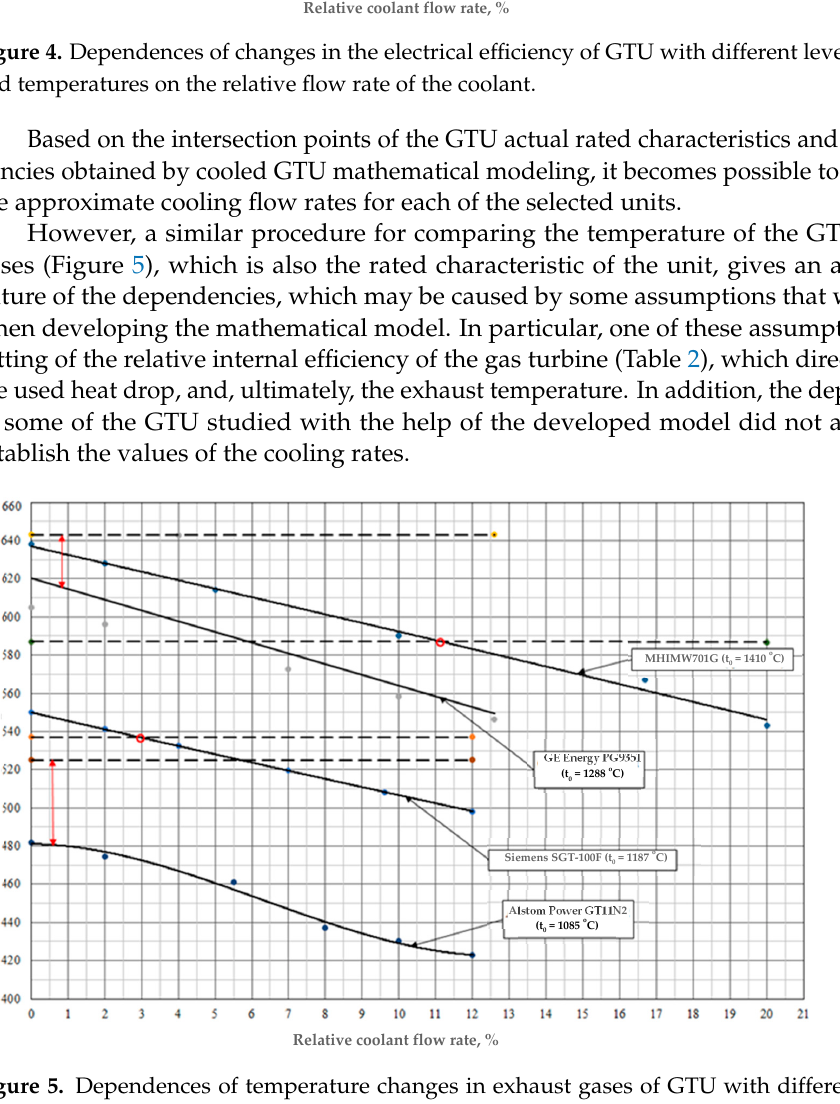
Figure 4. Dependences of changes in the electrical efficiency of GTU with different levels of power and temperatures on the relative flow rate of the coolant.